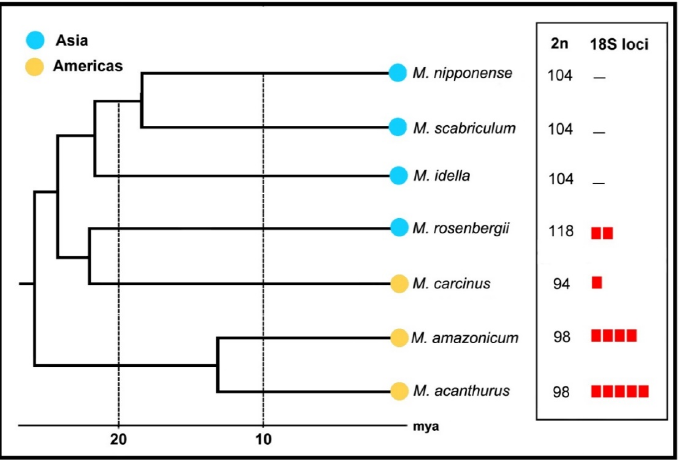
Figure 3. Diploid numbers and frequency of 18S-5.8S-28S rDNA loci in Macrobrachium species from a biogeographic and phylogenetic perspective. The red squares represent the number of chromosome pairs bearing these sequences (adapted from [55]).